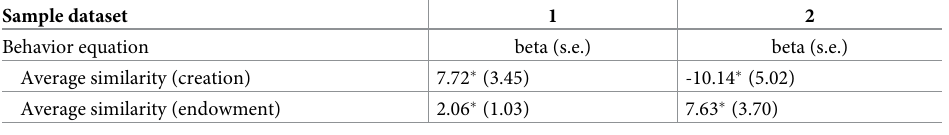
Table 4. Results from Stochastic Actor-Based models decomposing increase (creation function) and decrease (endowment function).